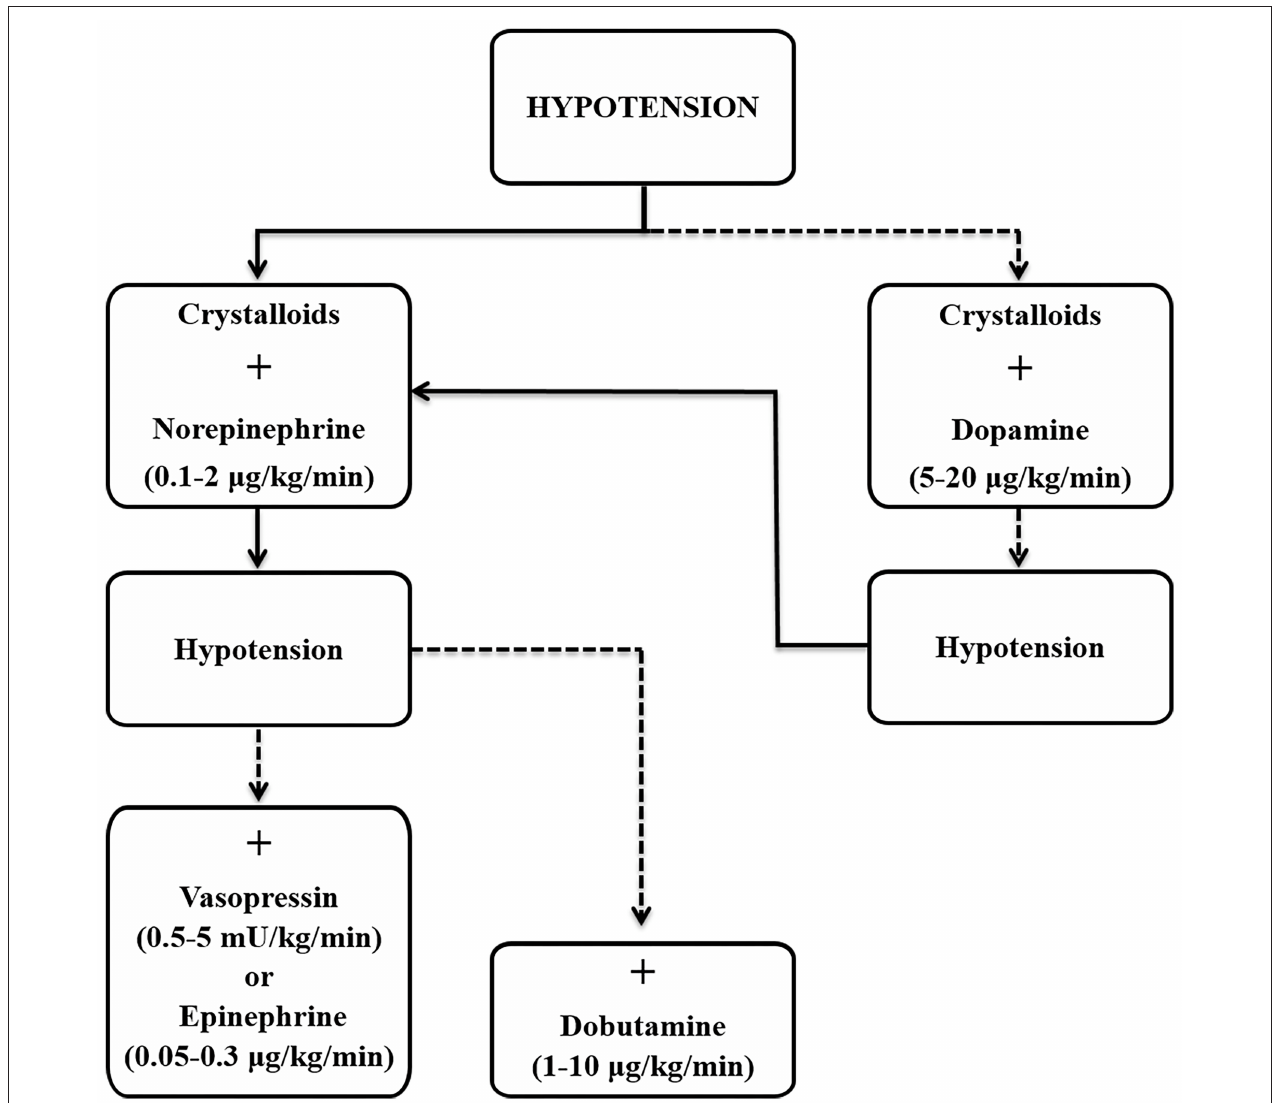
FIGURE 2 | Suggested approach for the treatment of hypotension based on current guidelines for management of sepsis and septic shock (72). Solid line, strong and preferred recommendation; dashed line, weaker